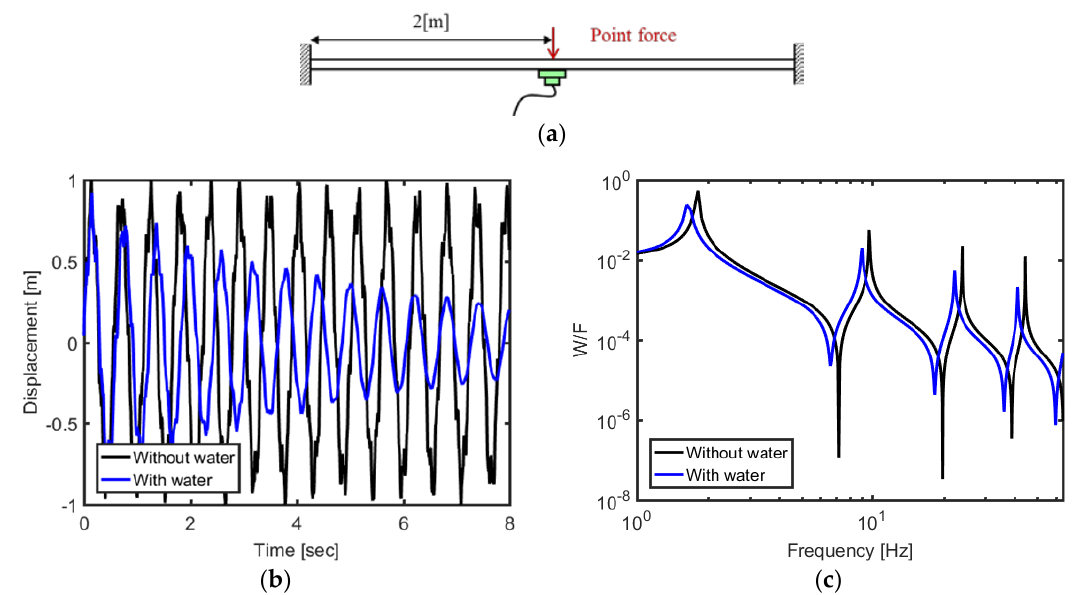
Figure 8. Fluid effects of flexural vibration of a single cylindrical beam in the fluid: ( a ) dynamic model of fixed–fixed beam; ( b ) flexural displacement; and, ( c ) frequency response function.